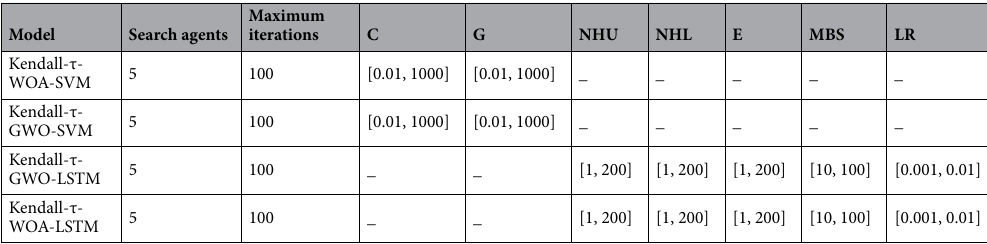
Table 4. The parameters setting of the proposed models.